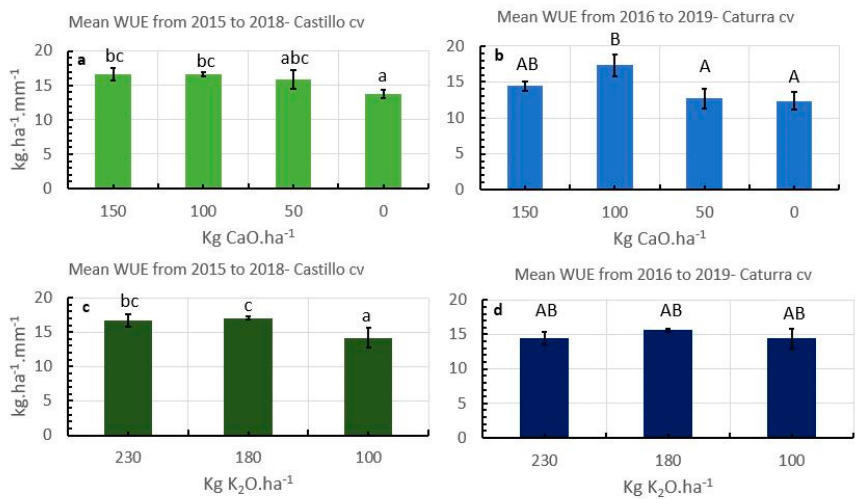
Figure 2. Influence of the calcium and potassium fertilization on water use efficiency in two coffee varieties, Castillo cv ( a , c ) and Caturra cv ( b , d ). Different letters indicate statistically significant differences in LSD test p < 0.05.